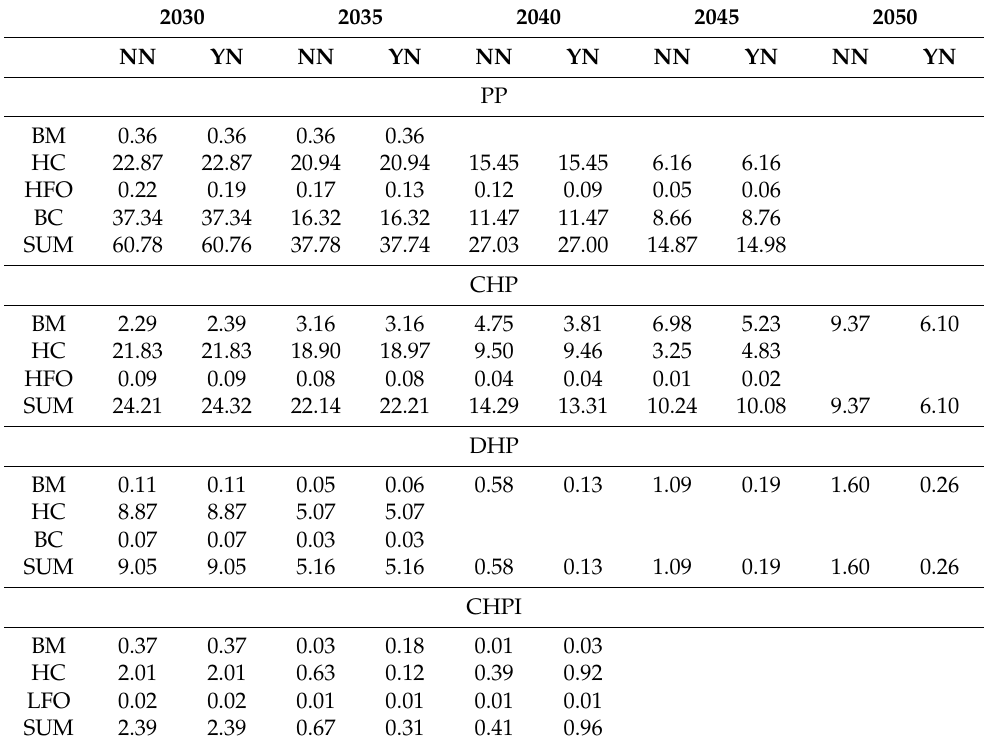
Table 5. Emission of SO 2 in 2030–2050 from various fuels (BM: biomass, HC: hard coal, HFO: heavy fuel oil, BC: brown coal, LFO: light fuel oil) from public power plants (PP), public combined heat and power plants (CHP), district heating plants (DHP), and industrial combined heat and power plants (CHPI) for non-nuclear (NN) and nuclear (YN) scenarios (kt). A blank field in the table means that a respective fuel is not used in a given model